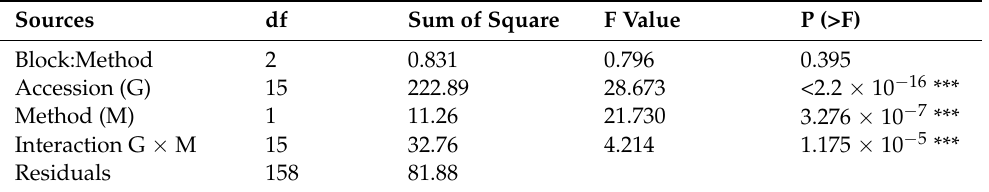
Table 3. Analysis of variance for effects of the melon accession (G), method of evaluation (M), and their interaction (GxM) on the P. xanthii Race 2 disease